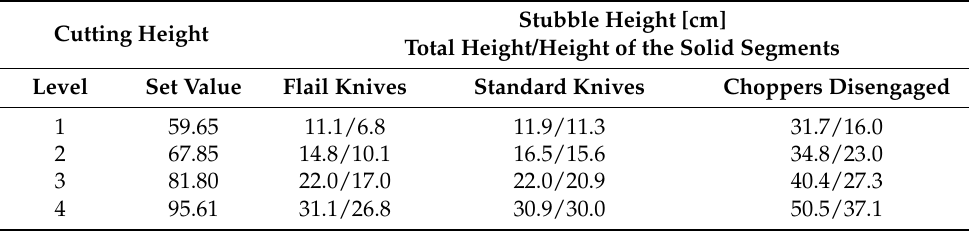
Table 2. Average corn stubble height depending on cutting height setting and corn header configuration.